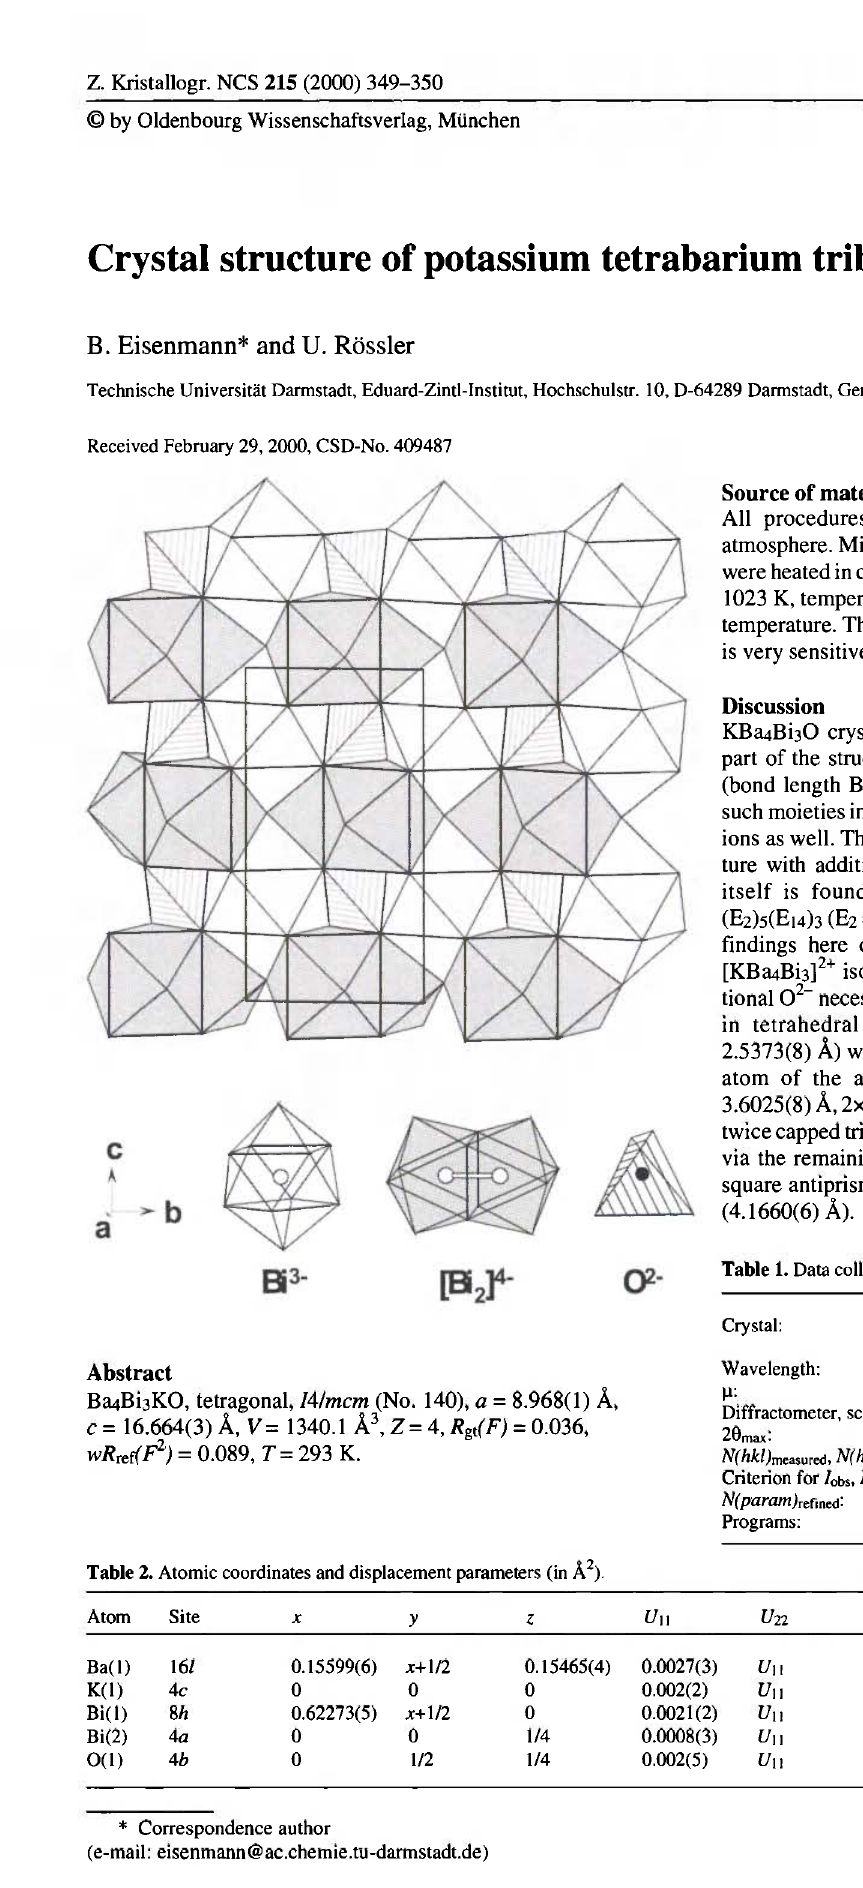
Table 2. Atomic coordinates and displacement parameters (in Ä 2